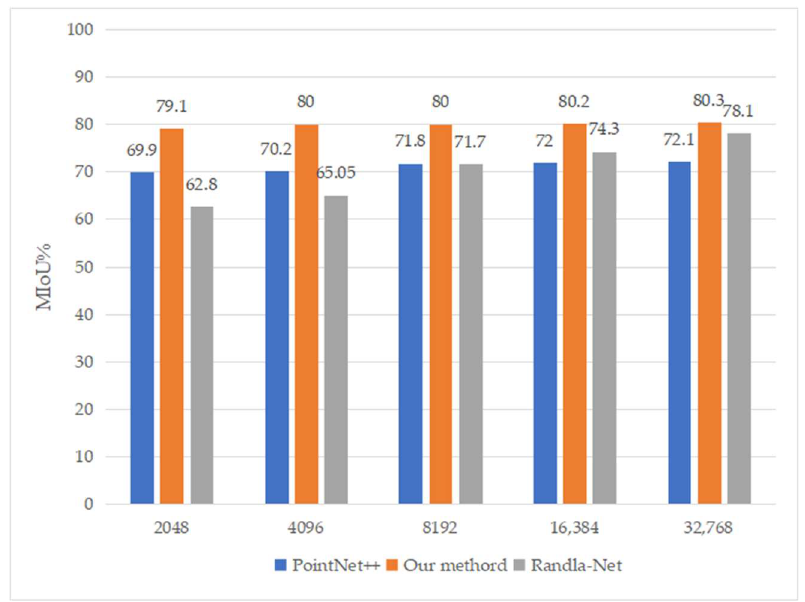
Figure 7. Overall segmentation accuracy based on different sampling parameters in Area